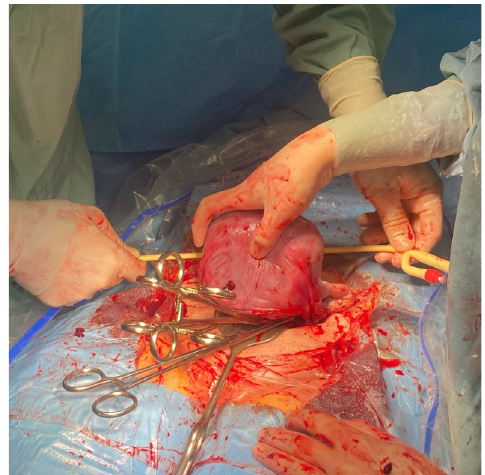
Figure 1. The assistant extracts the uterus from the abdomen by gently grasping the fundus of the uterus and pulling it upward and forward.